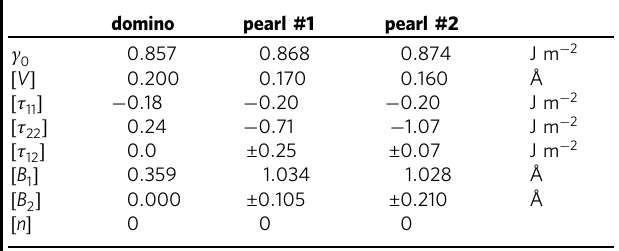
We follow the conventions used by Frolov and Mishin 36 , where index 1 corresponds to the tilt axis h 111 i , 2 corresponds to the h 347 i direction parallel to the GB, and 3 corresponds to the grain boundary normal h 11011 i . The signs of ½ τ 12 (cid:2) and ½ B (cid:2) depend on the choice of a speci fi c orientationof thephaseandthe coordinatesystem(seeSupplementaryFig.5fordetails). ½ B 3 (cid:2) is equal to ½ V (cid:2) when [ n ] =